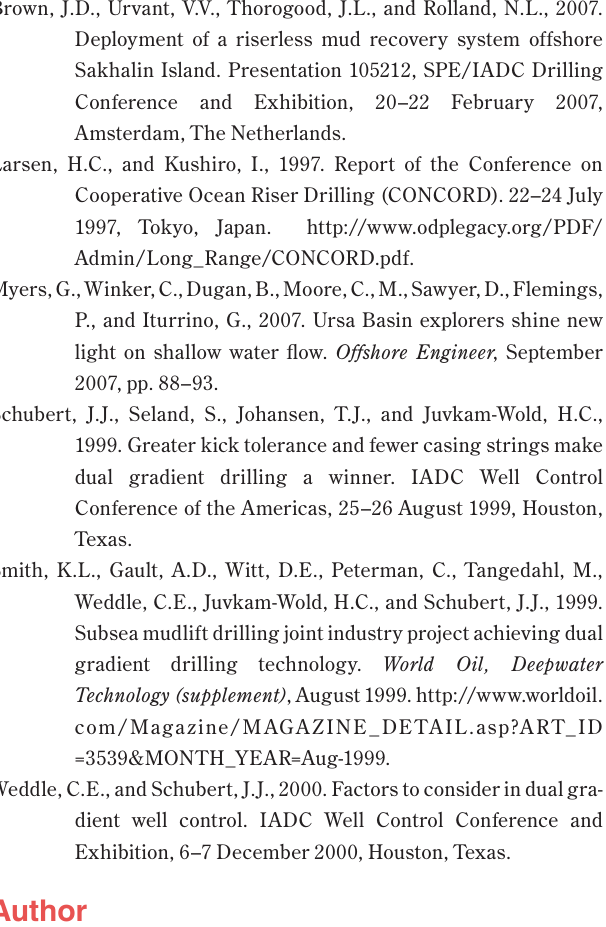
Figs. 4 and 5: courtesy of John Thorogood (Drilling GlobalDrilling Global Consultant LLP))